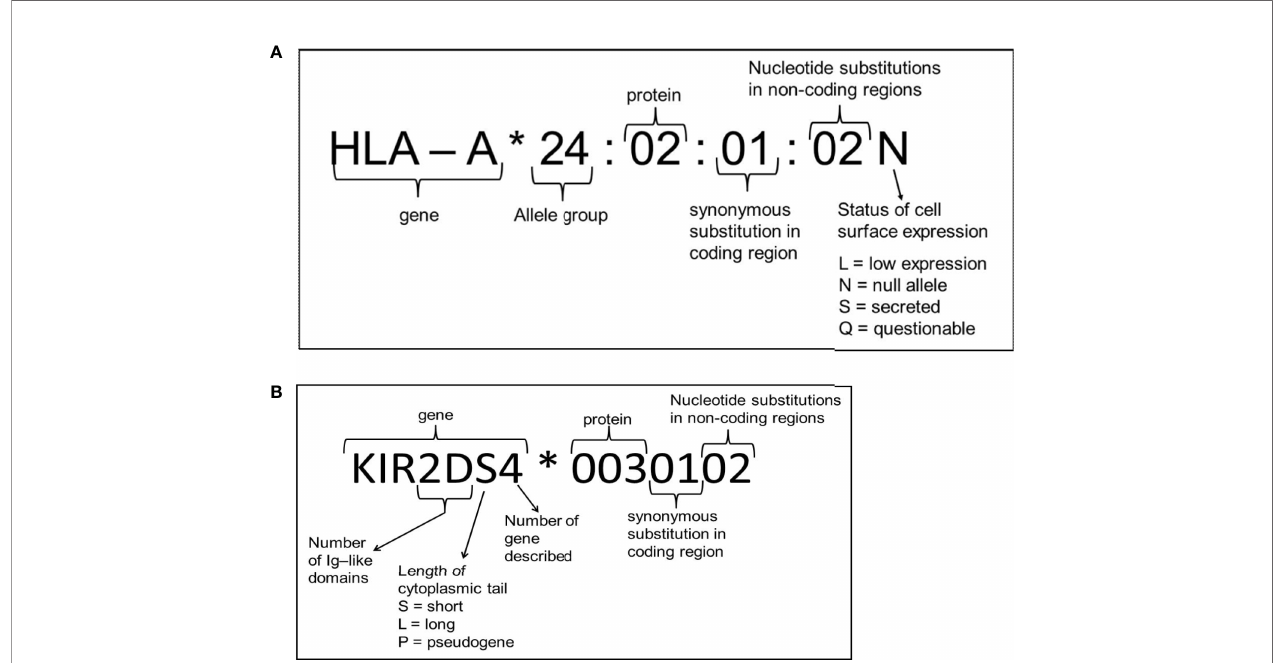
FIGURE 3 | Explanation of nomenclature used for HLA (A) and KIR (B) . Figure adapted from the IPD-IMGT/HLA and IPD-KIR database website, respectively (85,